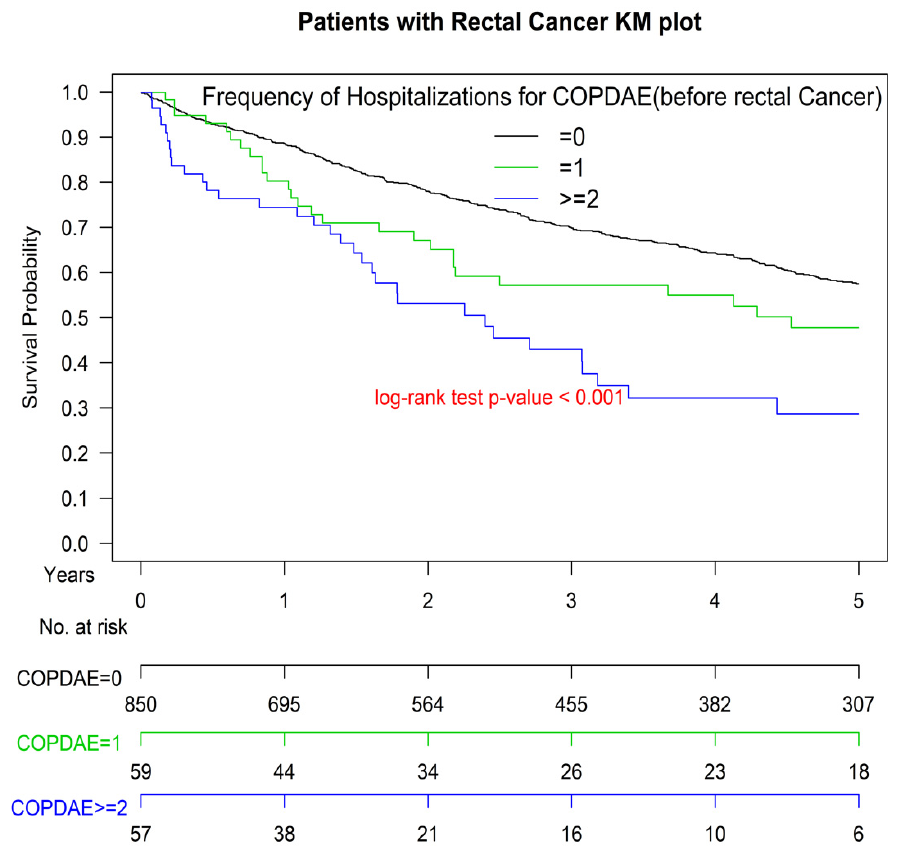
Figure 2. Kaplan–Meier survival curves of patients with rectal adenocarcinoma with hospitalization(s) for acute exacerbations of chronic obstructive pulmonary disease within 1 year before surgery. COPDAE, chronic obstruction pulmonary disease with acute exacerbation.